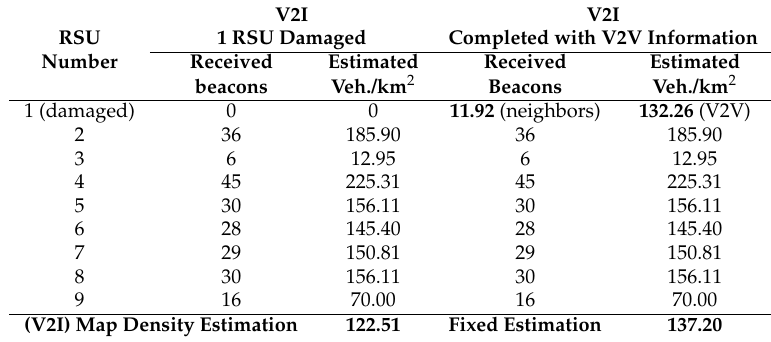
Table 9. Estimated vehicle density when simulating 150 vehicles/km 2 in San Francisco when 1 RSU was broken. V2I V2I RSU 1 RSU